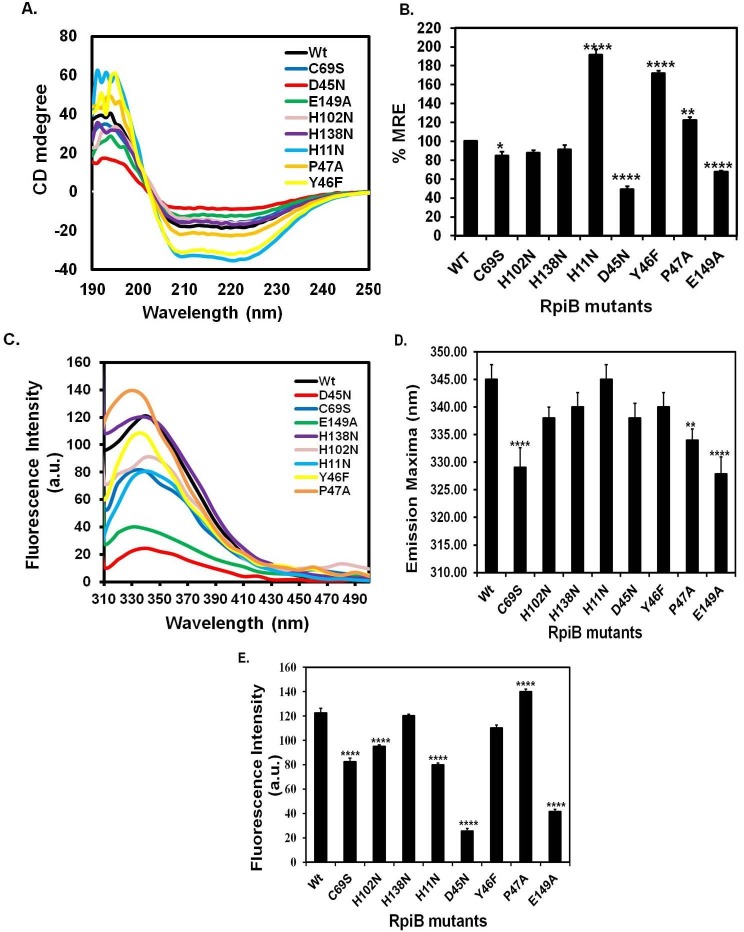
Biophysical analysis of LdRpiB wild type (wt) and various mutants.(A) CD spectra of LdRpiB and its mutants from 190–250 nm. (B) Changes in percentage mean residue ellipticity of LdRpiB and its mutants. Data represents the mean ± S.D. from three experiments performed in duplicates, * represents p ≤ 0.05, ** represents p ≤ 0.01 and *** represents p ≤ 0.001. (C) Fluorescence Emission spectra at 290 nm wavelength. (D) and (E) Changes observed in the emission maxima and fluorescence intensity of wild type RpiB and its mutants respectively. Data represents the mean ± S.D. from three experiments performed in duplicates, * represents p ≤ 0.05, ** represents p ≤ 0.01 and *** represents p ≤ 0.001.